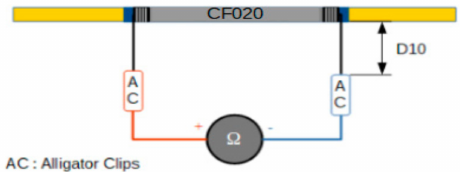
Figure 3. Diagram of the resistance measurement of sensor yarn with an ohmmeter using alliga- tor